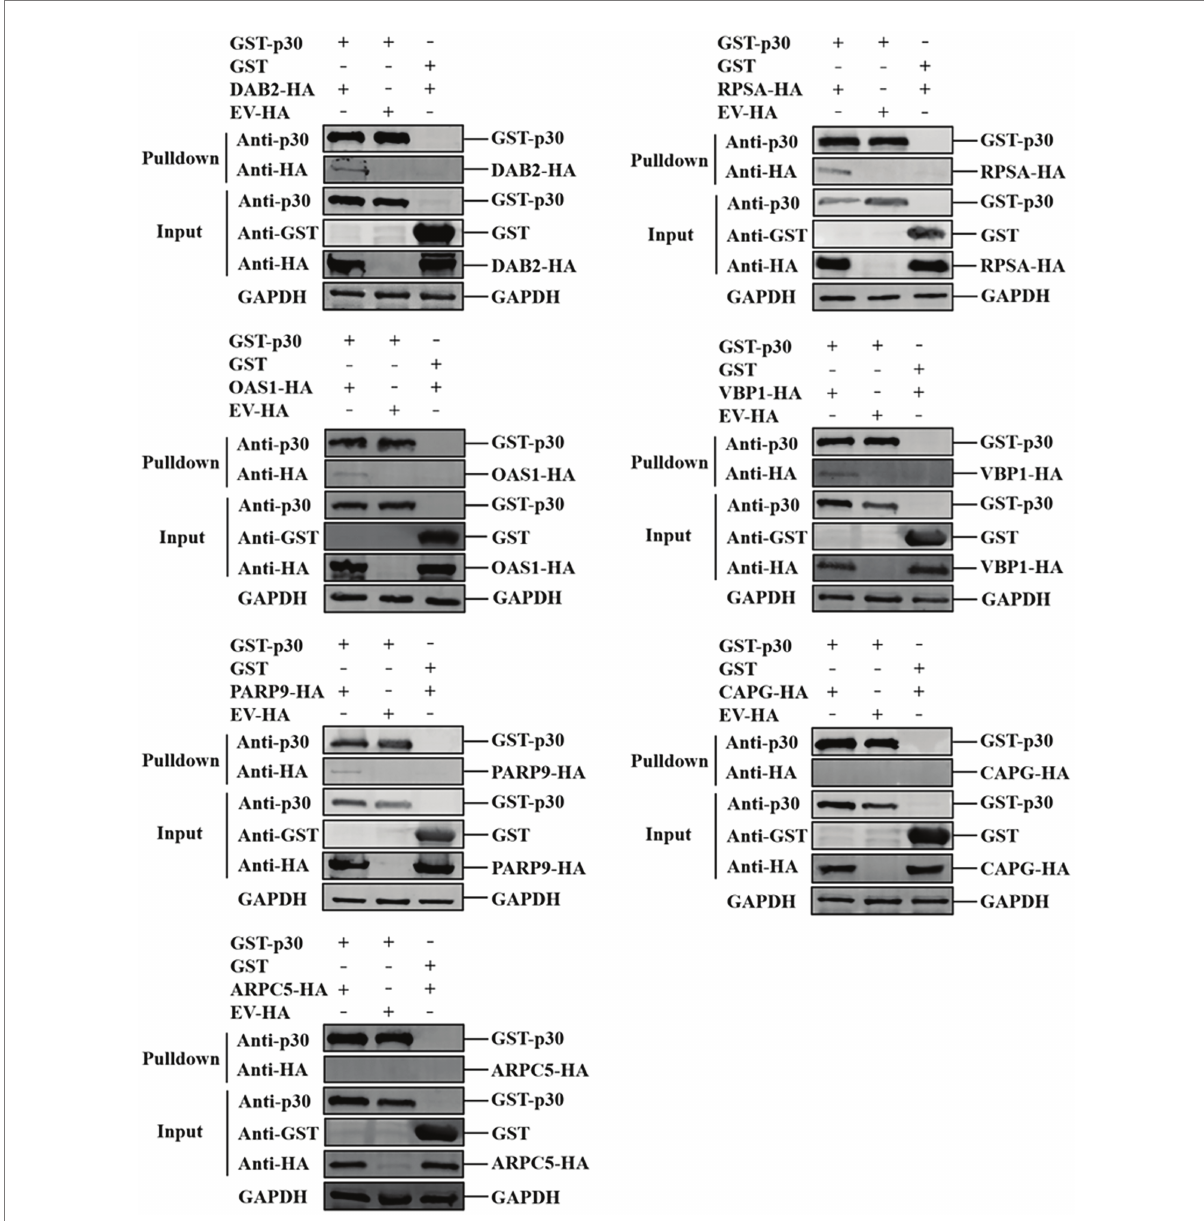
FIGURE 4 Verification of ASFV p30-cell protein interaction using GST-Pulldown assay. ASFV p30 bound to the recombinant Dab2, RPSA, OAS1, VBP1, PARP9, CAPG, or ARPC5. The GST-p30 recombinant proteins were expressed in prokaryotic cells, purified with GST beads, then incubated with lysate of HEK-293 T cells expressing HA-Dab2, HA-RPSA HA-OAS1, HA-VBP1, HA-PARP9, HA-CAPG, or HA-ARPC5. After washing with cold-PBS, the eluted complexes were determined by immunoblotting and detected with specific